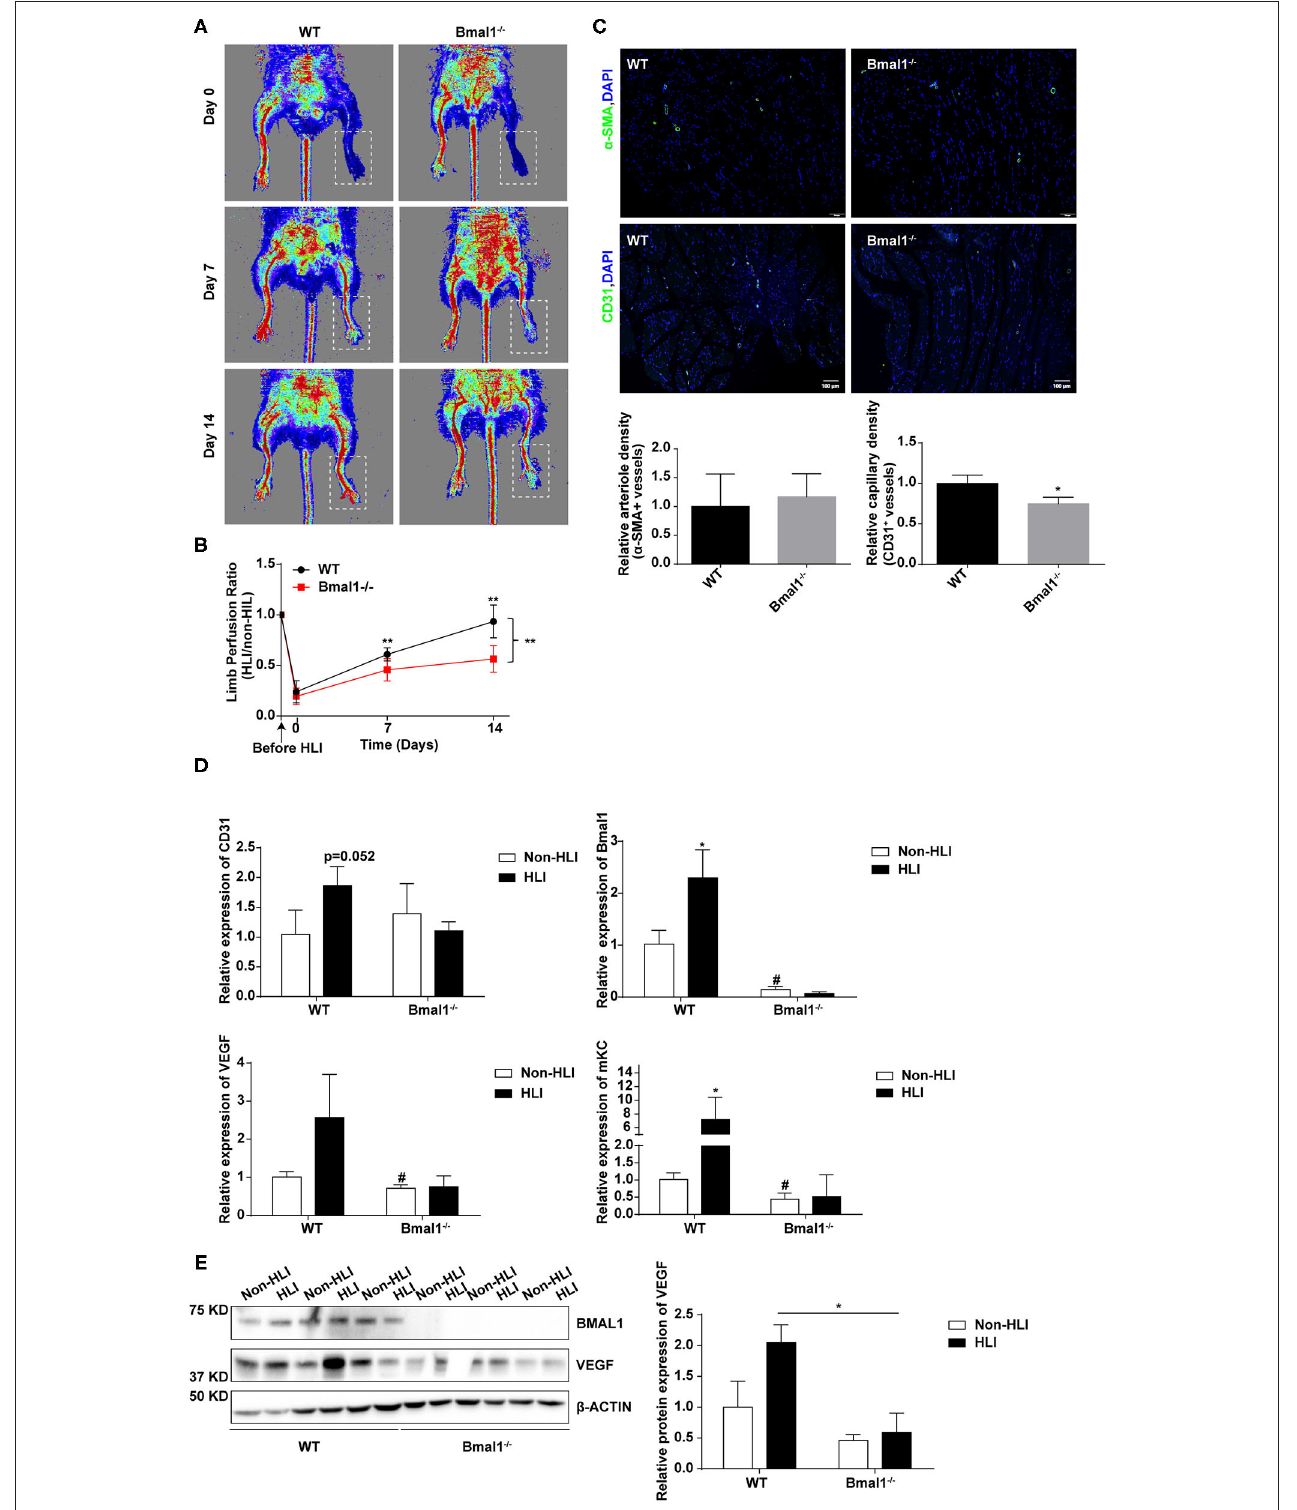
FIGURE 5 | Bmal1 promotes angiogenesis after peripheral ischemic injury. (A) Blood flow obtained via laser Doppler perfusion imaging on days 0, 7, and 14 after HLI in Bmal1 − / − mice and WT mice. (B) The perfusion of the hindlimbs of mice at each time point was calculated as the ratio of measurements of the injured (HLI)